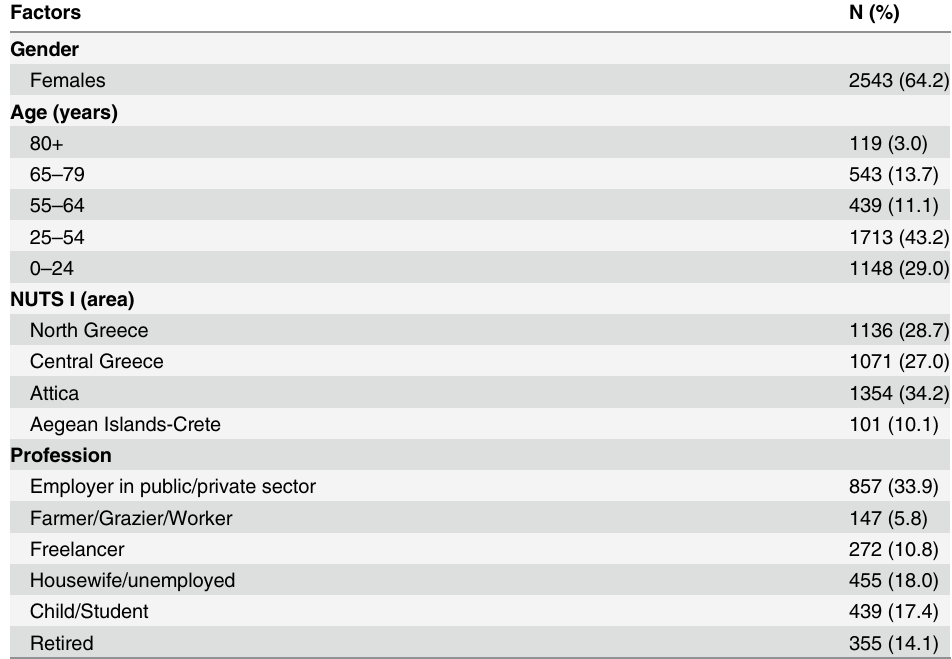
Table 1. Study population